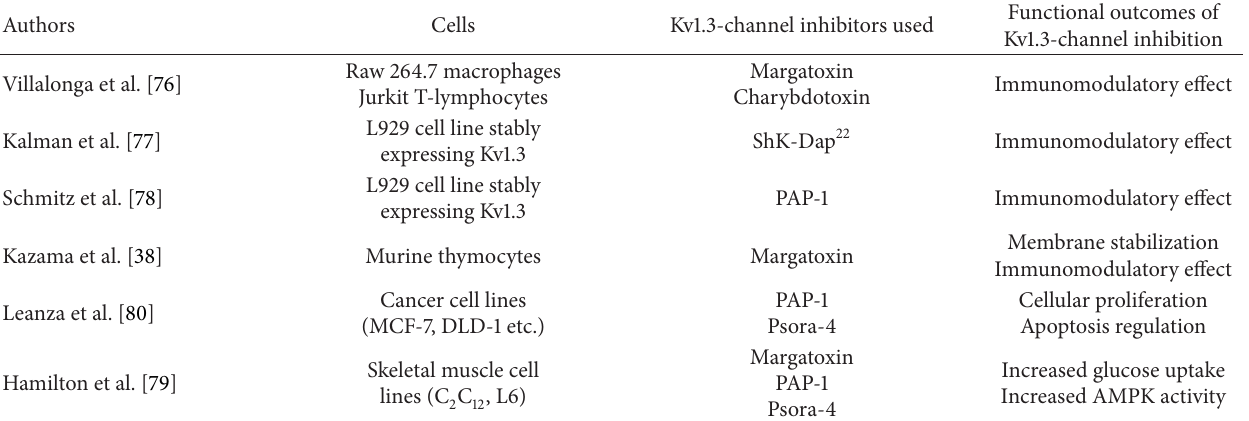
Table 2: Summary of Kv1.3-channel inhibition and its functional